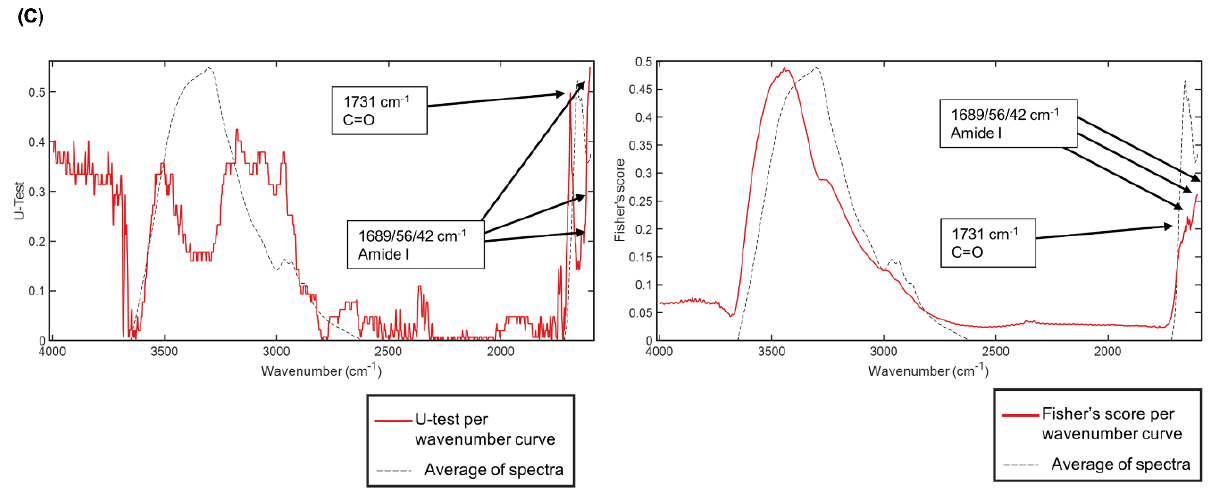
Figure 4. Infrared spectral biomarkers of hBA-CM. ( A ) The differences between mean spectra of hBA-CM and hWA-CM. ( B ) PCA-LDA cluster vector for hBA-CM. ( C ) U-test, and Fisher’s score per wavenumber for hBA-CM). − log(0.05) = 1.3, significance level.